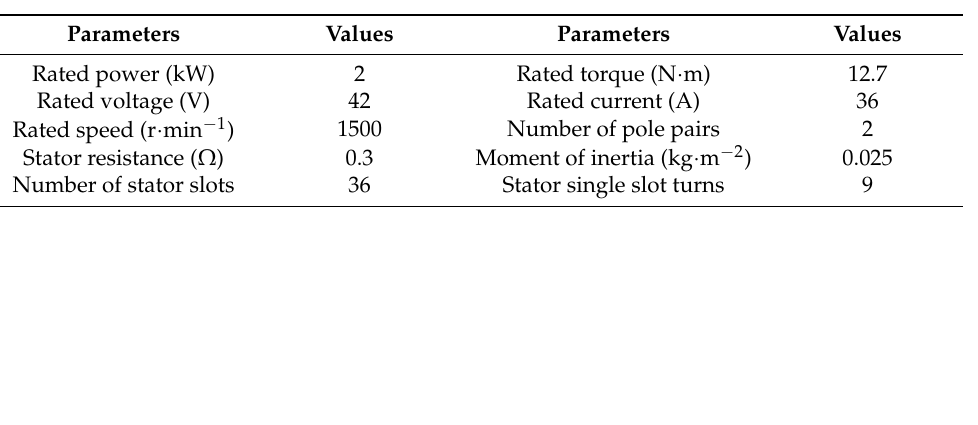
Table 1. Parameters of the synchronous reluctance motor